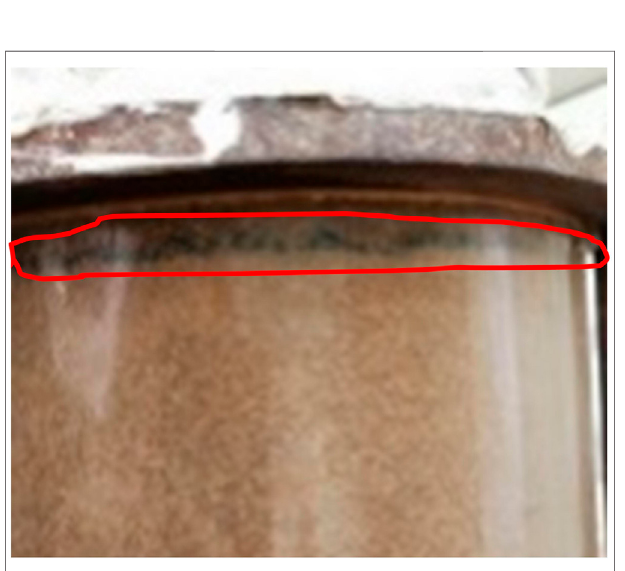
FIGURE11| Comparisonofmoisturedistributioninacyclicdiurnaltemperaturevariationwhenthelightturnson14 h(daytime)andturnsoff10 h(night)atdifferent times. (A) 1 day; (B) 3 days; (C) 7 days; (D) 10 days; (E) 20 days; (F) 30 days.